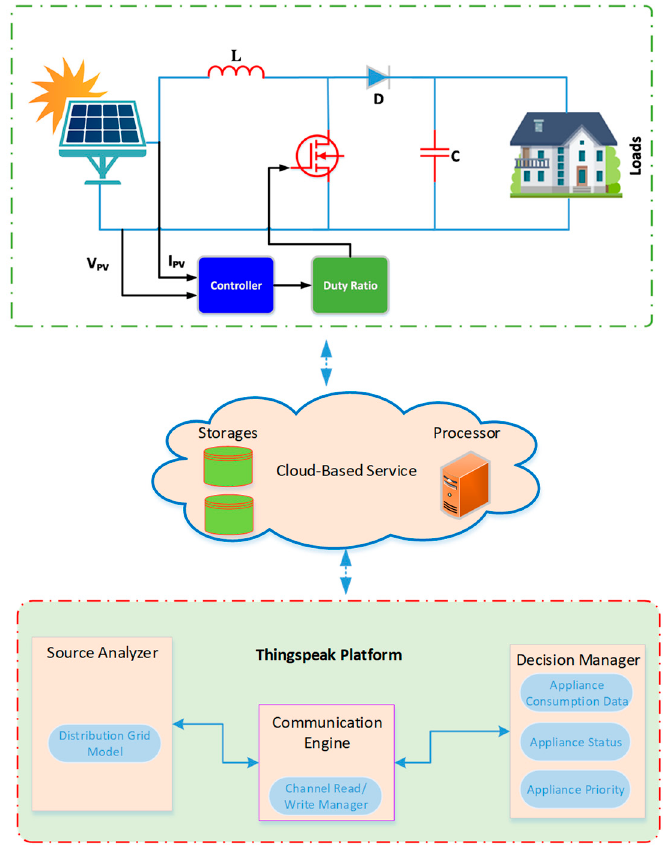
Figure 11. Proposed smart home architecture of communication.